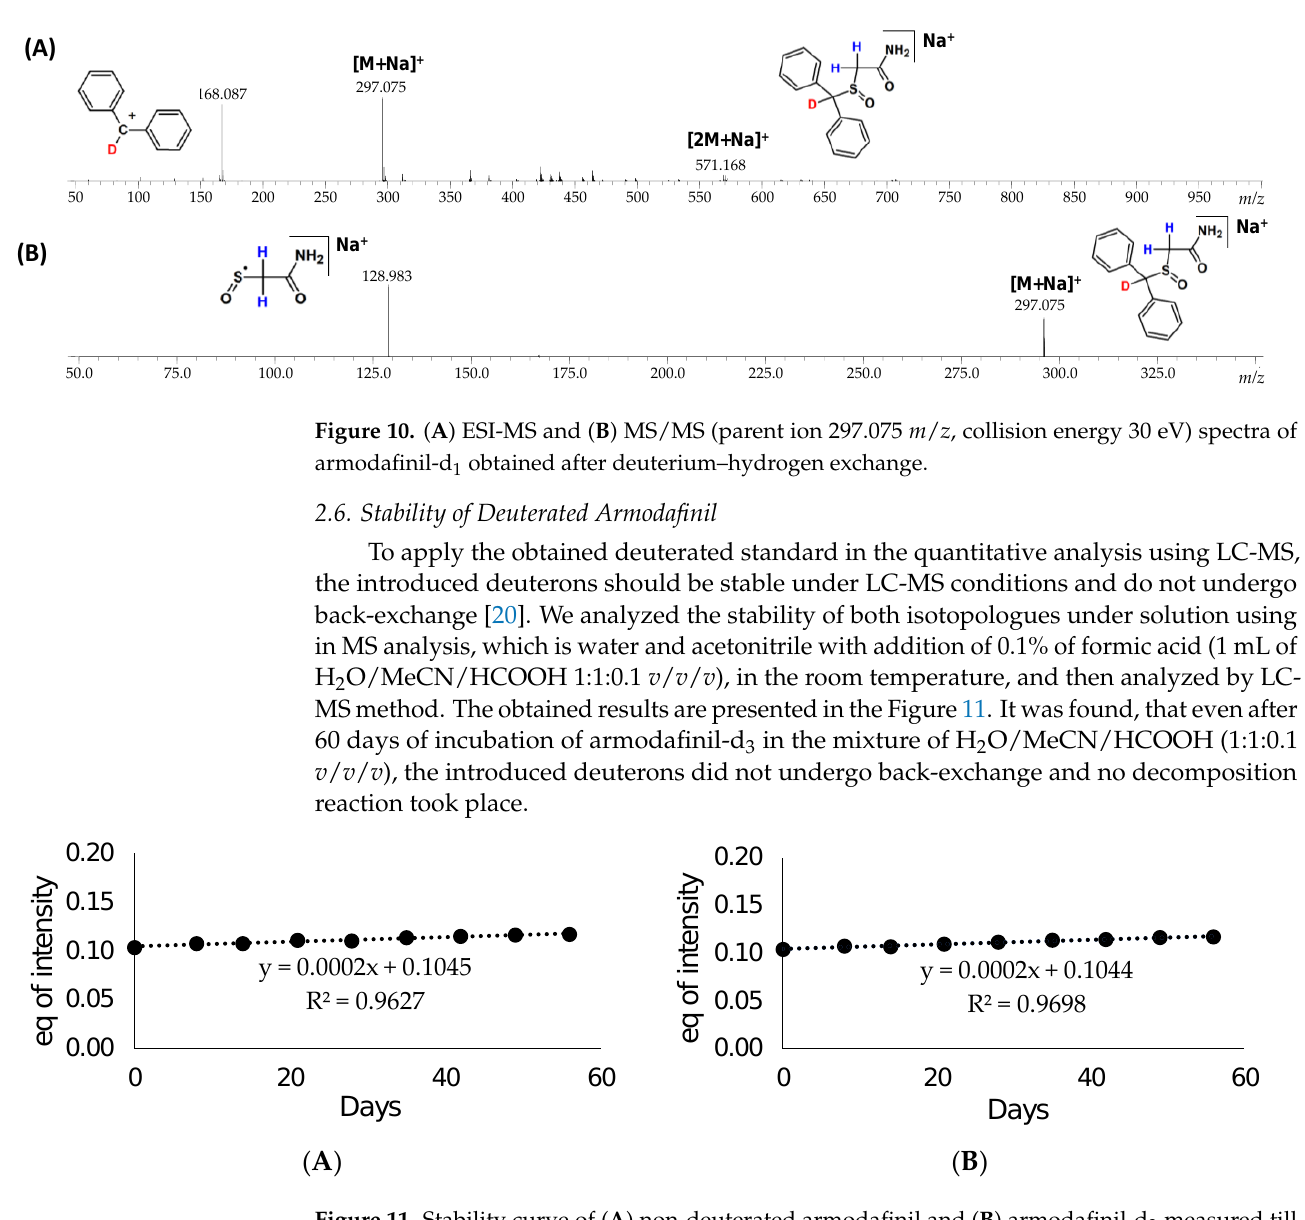
Figure 11. Stability curve of ( A ) non-deuterated armodafinil and ( B ) armodafinil-d 3 measured till two months for the ion ( A ) 296.071 m/z and ( B ) 299.088 m/z .